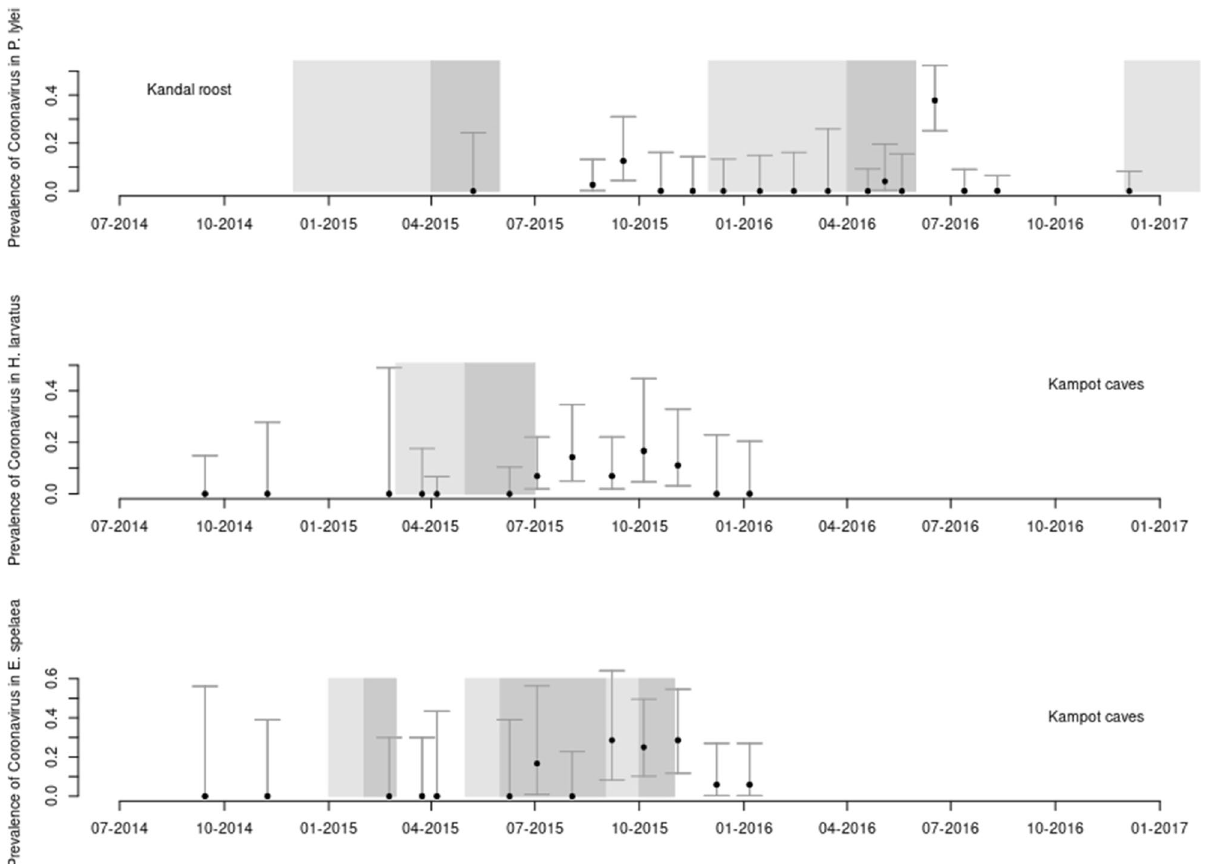
Figure 2. Results of the longitudinal sampling of three bat species for coronaviruses. The first graph shows estimation of the coronavirus prevalence (with CI95) for Pteropus lylei at the second study site in Kandal province. The second and third graph show the same for Hipposideros larvatus s.l. and Eonycteris spelaea (respectively) at the first study site in Kampot province. The light grey areas show periods when pregnant females were captured, whereas dark grey areas show periods when lactating females were captured.